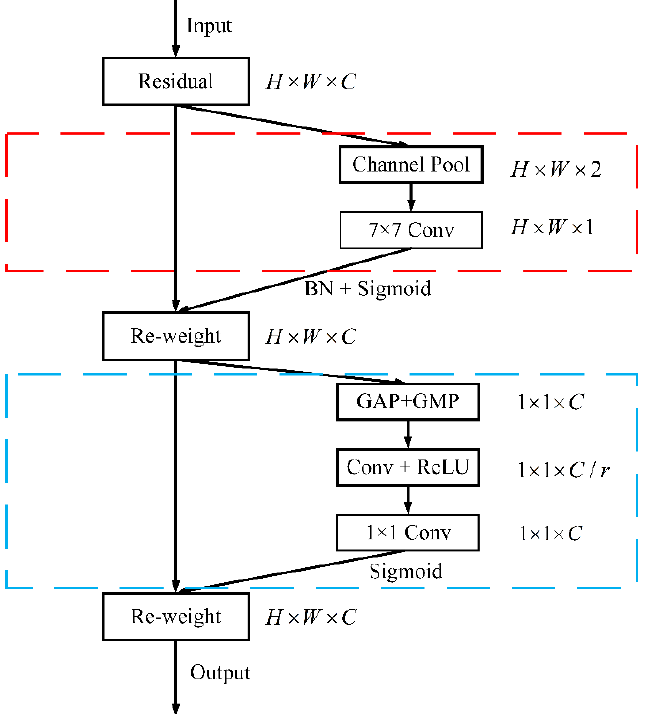
Figure 11. Schematic diagram of CBAM attention mechanism module.